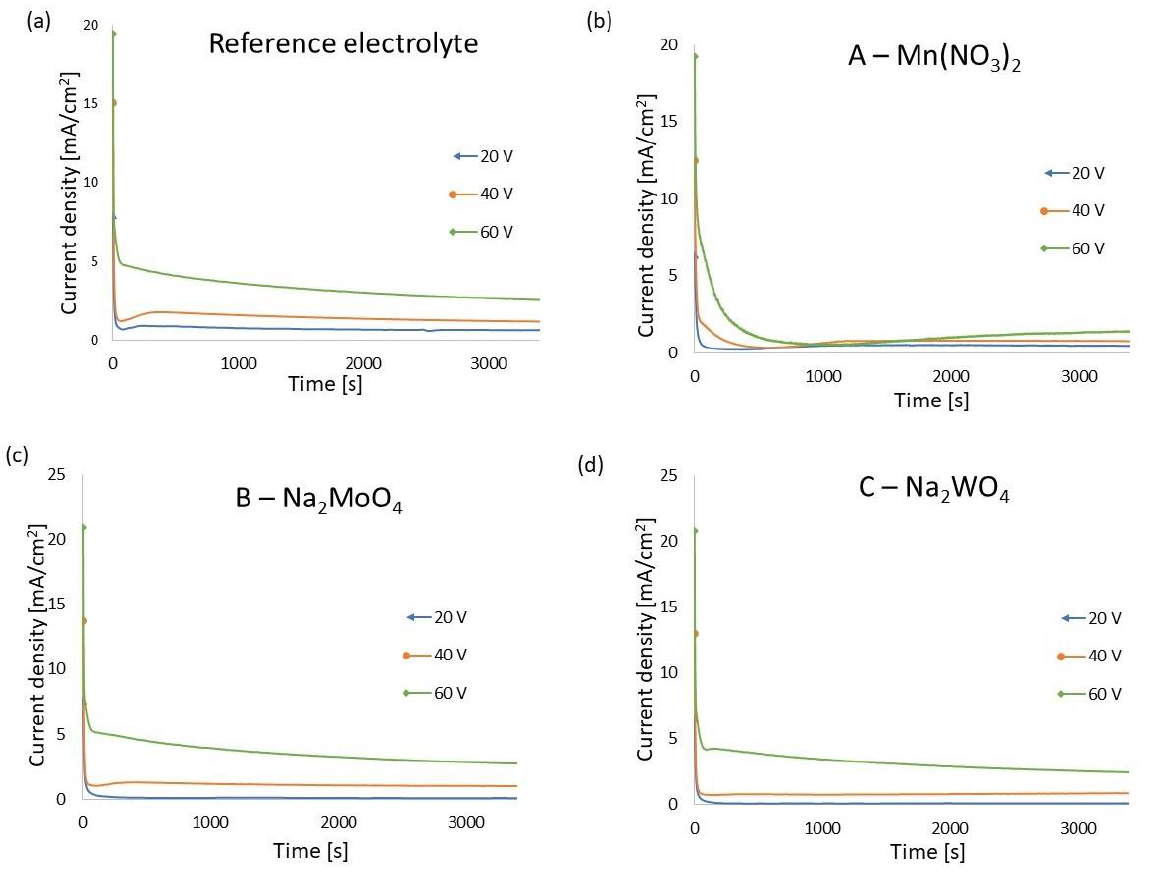
Figure 1. Current curves registered during anodization of titanium in reference ( a ), A—Mn(NO 3 ) 2 ( b ), B—Na 2 MoO 4 ( c ), and C—Na 2 WO 4 ( d ) electrolytes at 20 V, 40 V, and 60 V.